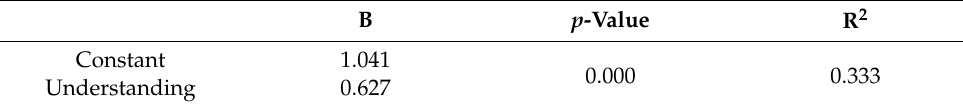
Table 7. Regression